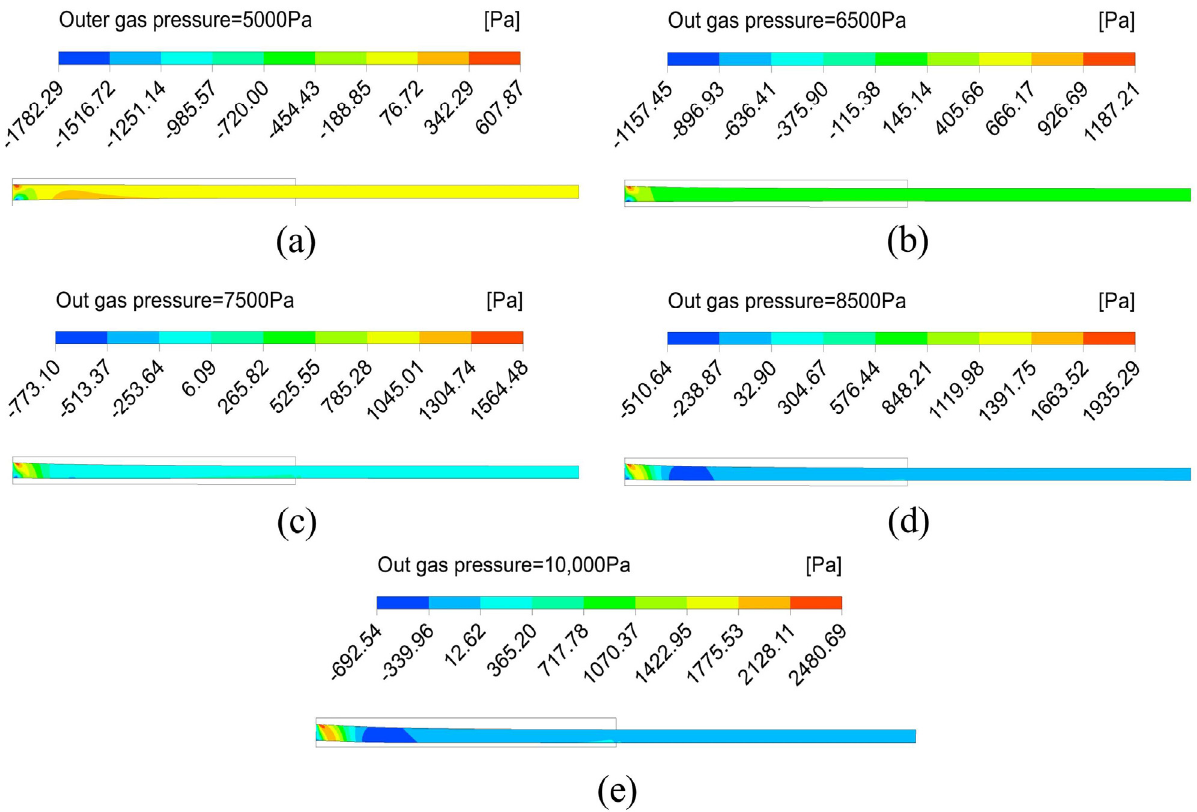
Figure 7. The distribution of melt first normal stress difference under different pressure of the outer gas cushion layer.( a ) The pressure of the outer gas layer is 5000 Pa; ( b ) The pressure of the outer gas layer is 6500 Pa; ( c ) The pressure of the outer gas layer is 7500 Pa; ( d ) The pressure of the outer gas layer is 8500 Pa; ( e ) The pressure of the outer gas layer is 10,000 Pa.